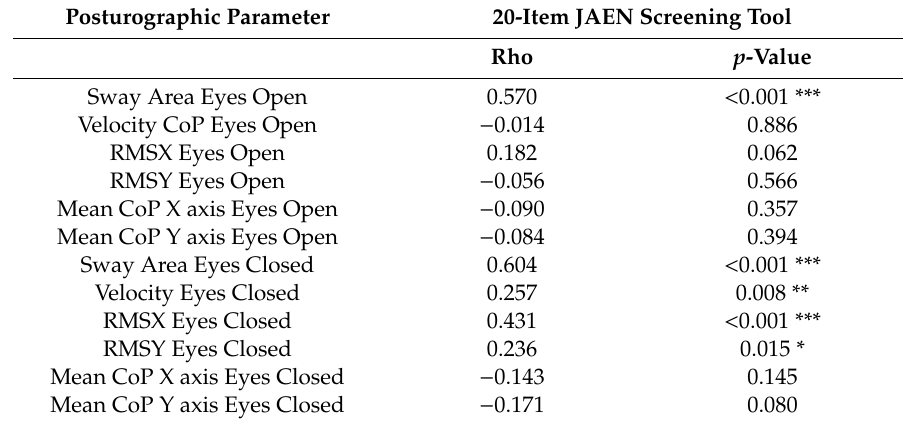
Spearman correlations between the 20-item JAEN screening tool and posturographic